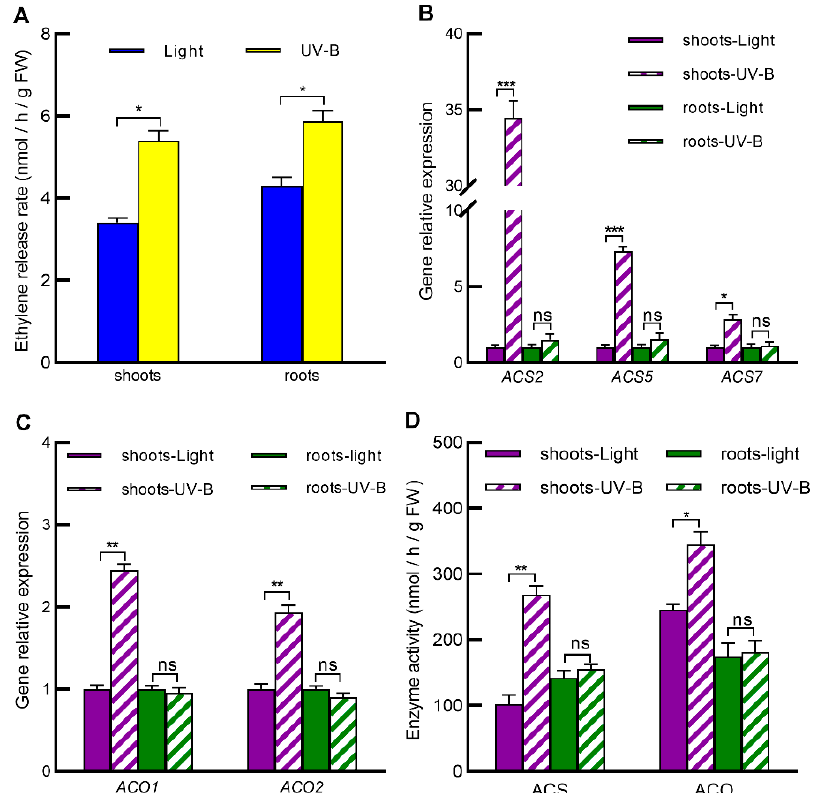
Figure 5. UV-B enhanced ethylene levels in both shoots and roots by only increasing ethylene biosynthesis in Arabidopsis shoots. Seedlings of Arabidopsis wild-type Col-0 grown in vermiculite substrate were exposed to light alone (Light) or with 0.5 W/m 2 UV-B (UV-B) for 3 h. Then, shoots and roots were harvested and subjected to determination of ethylene release rates ( A ), gene expression of ACS ( B ) and ACO ( C ), and activities ( D ) of ethylene biosynthetic enzymes ACS and ACO. Values are means ± SE of three biological replicates, each pooled more than thirty plants. Data of gene relative expression are presented as values relative to those under light treatment after normalization to those of ACTIN2 . Data with asterisks indicate significant differences between light and UV-B treatments (* p < 0.05; ** p < 0.01; *** p < 0.005; ns: no significant difference).